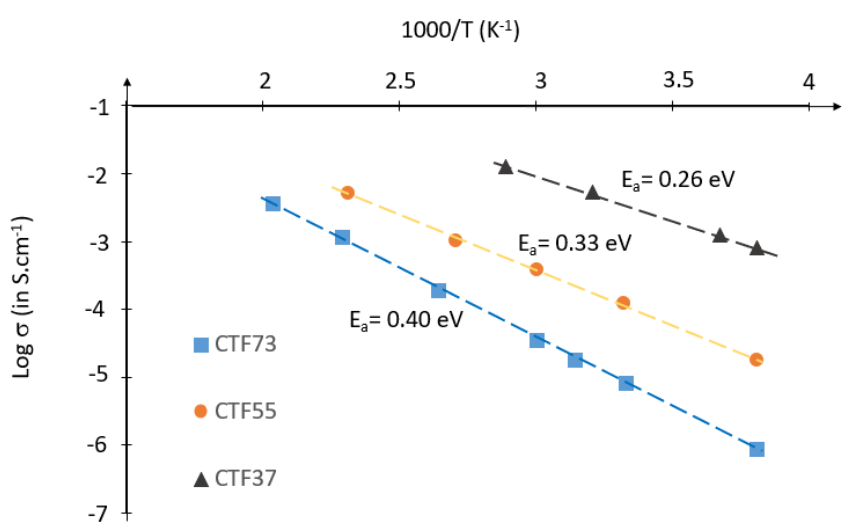
Figure 6. Arrhenius plot of electrical conductivity (S.cm −1 ) of CaTi 1−y Fe y O 3−δ perovskite pellets ver- sus 1/T (K −1 ). versus 1/T (K − 1